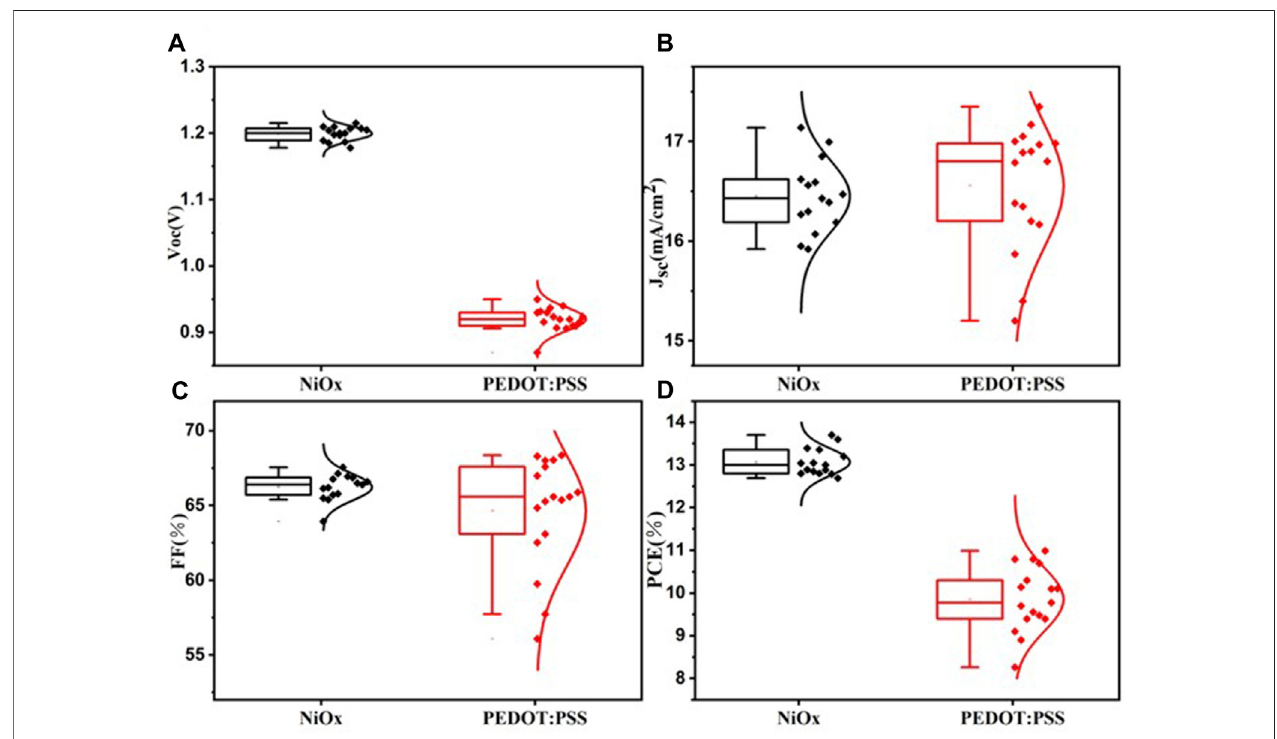
FIGURE 3 | Dependence of photovoltaic parameters of the NiO x - and PEDOT:PSS – based perovskite devices. The data were statistically analyzed from ∼ 15 cells.